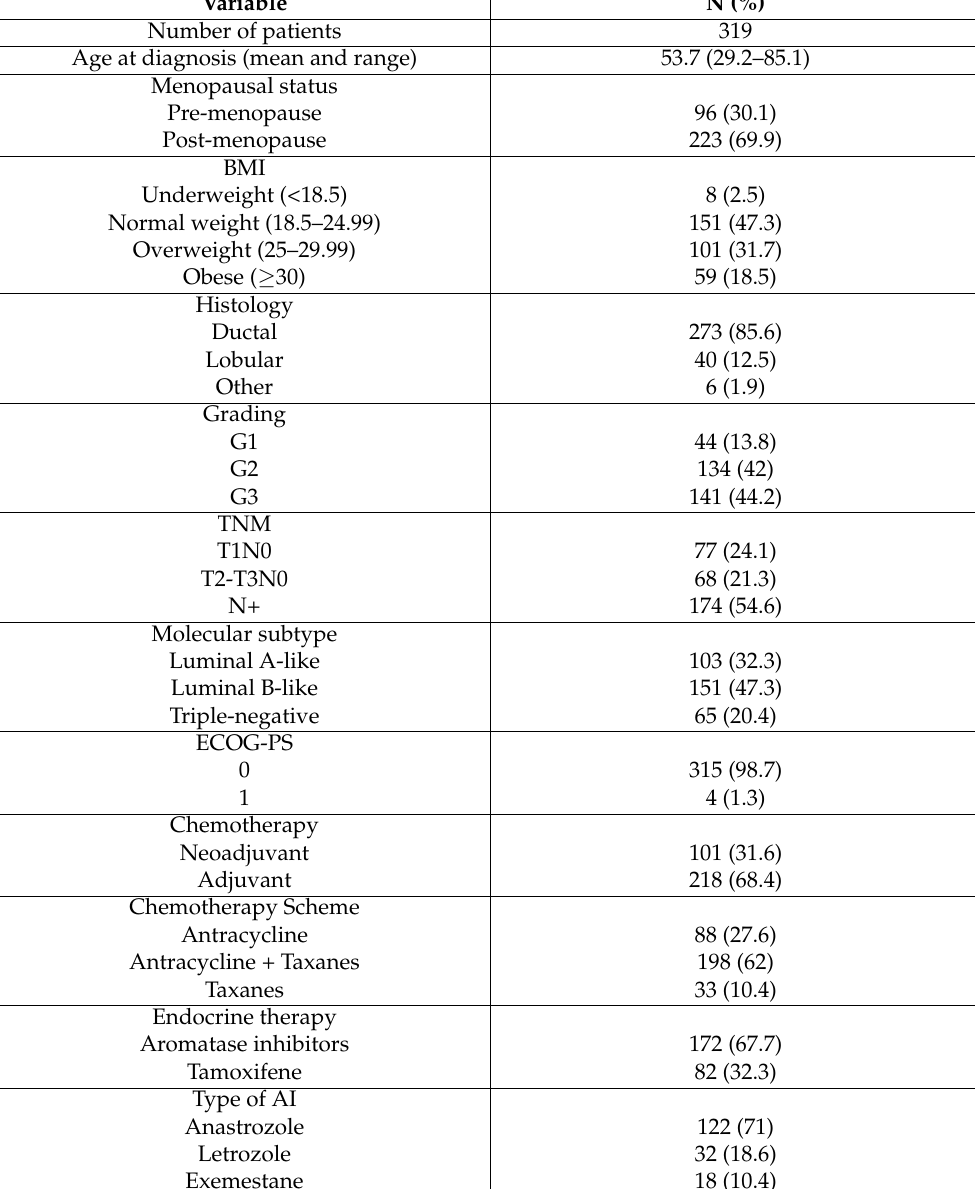
Table 1. Non metastatic, HER2-negative BC patients’ clinical and pathological characteristics.